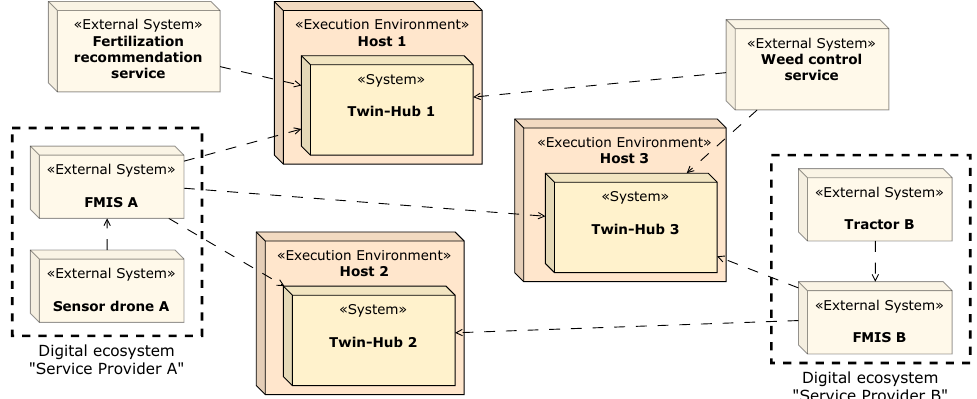
Figure 5. Example deployment diagram of a federated network of Twin-Hubs (interfaces are omitted for the sake of